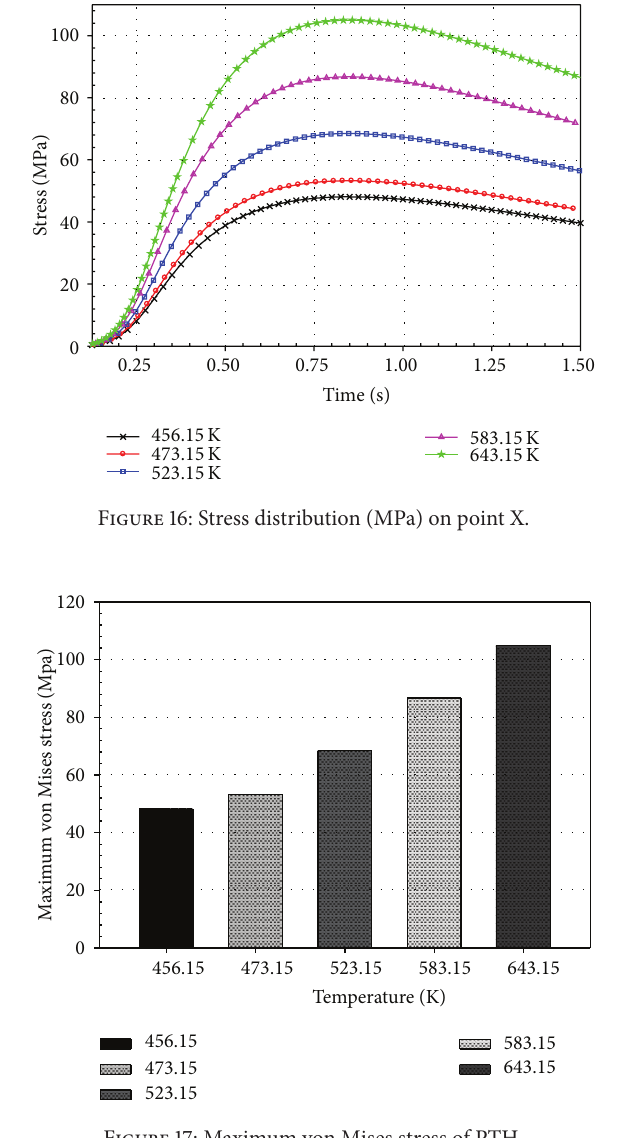
Figure 17: Maximum von Mises stress of